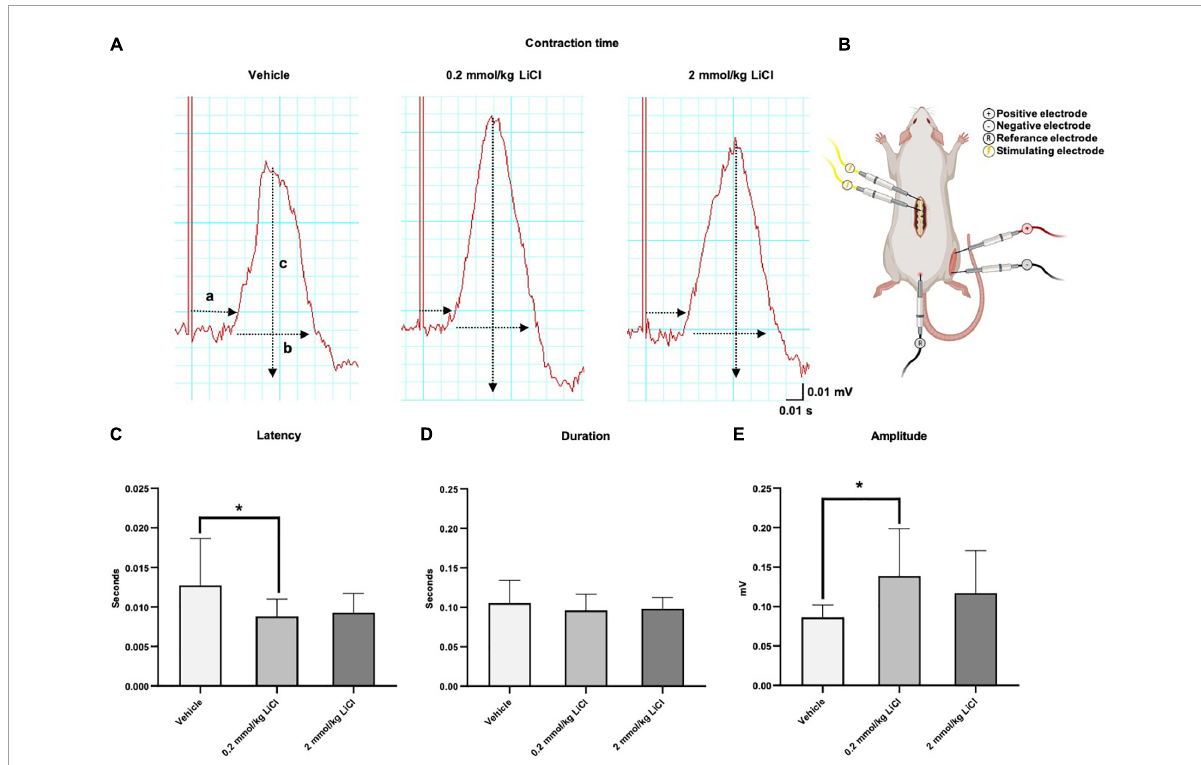
FIGURE2 Low-dose lithium enhances functional EMG responses evoked by spinal cord stimulation. (A) Representative electromyograms (EMG) obtained in the right-sided gastrocnemius muscle after electrical stimulation of the spinal cord of mice exposed to spinal cord hemitransection, which were treated with vehicle or lithium (0.2 or 2 mmol/kg/day) for 56 days (a: Latency, b: Duration, c: Amplitude). (B) Schematic illustration of the electrical stimulation site at the T7 level of the spinal cord and the EMG recording site in the gastrocnemius muscle. After lithium treatment at 0.2 mmol/kg/day but not 2 mmol/kg/day, (C) the latency of the evoked potential decreased, (D) the duration of the potential remained unchanged and (E) the amplitude increased. Data are mean ± SD values ( n = 16 animals/group). * p < 0.05 for 0.2 mmol/kg LiCl vs.